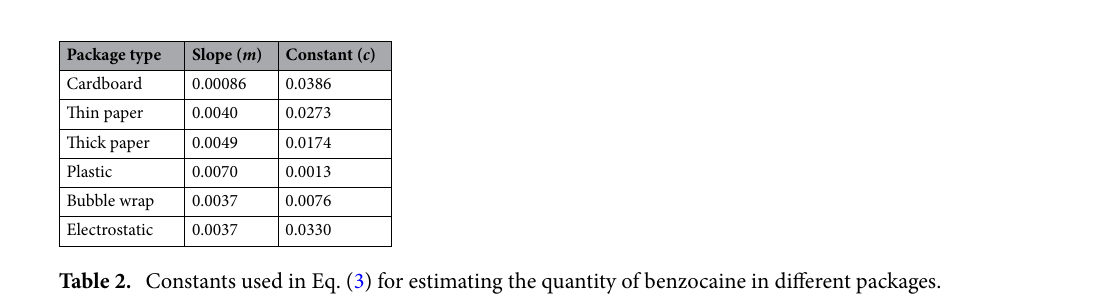
Table 2. Constants used in Eq. (3) for estimating the quantity of benzocaine in different packages.